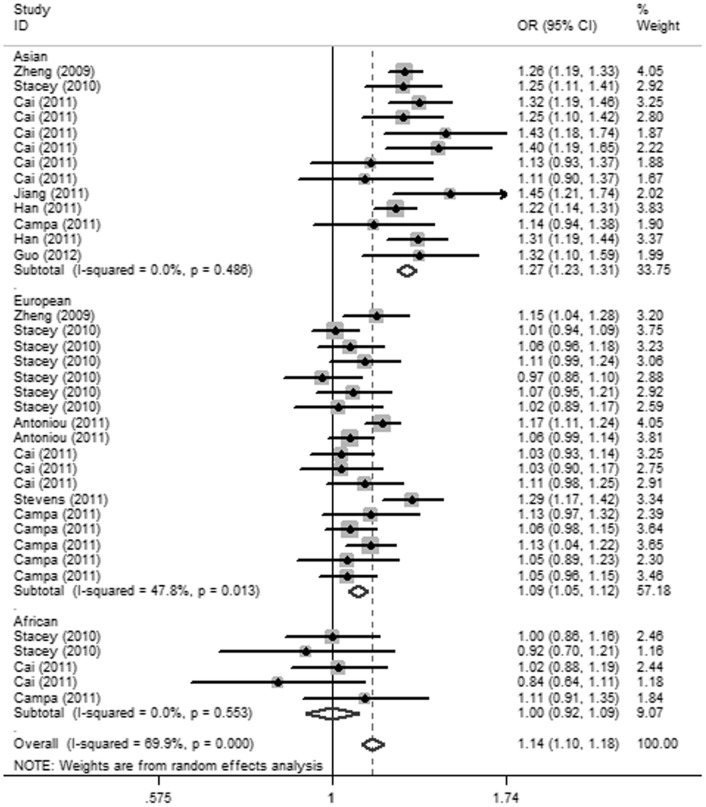
Forest plot of association between rs2046210 and BC risk in different ethnicities under allelic model.